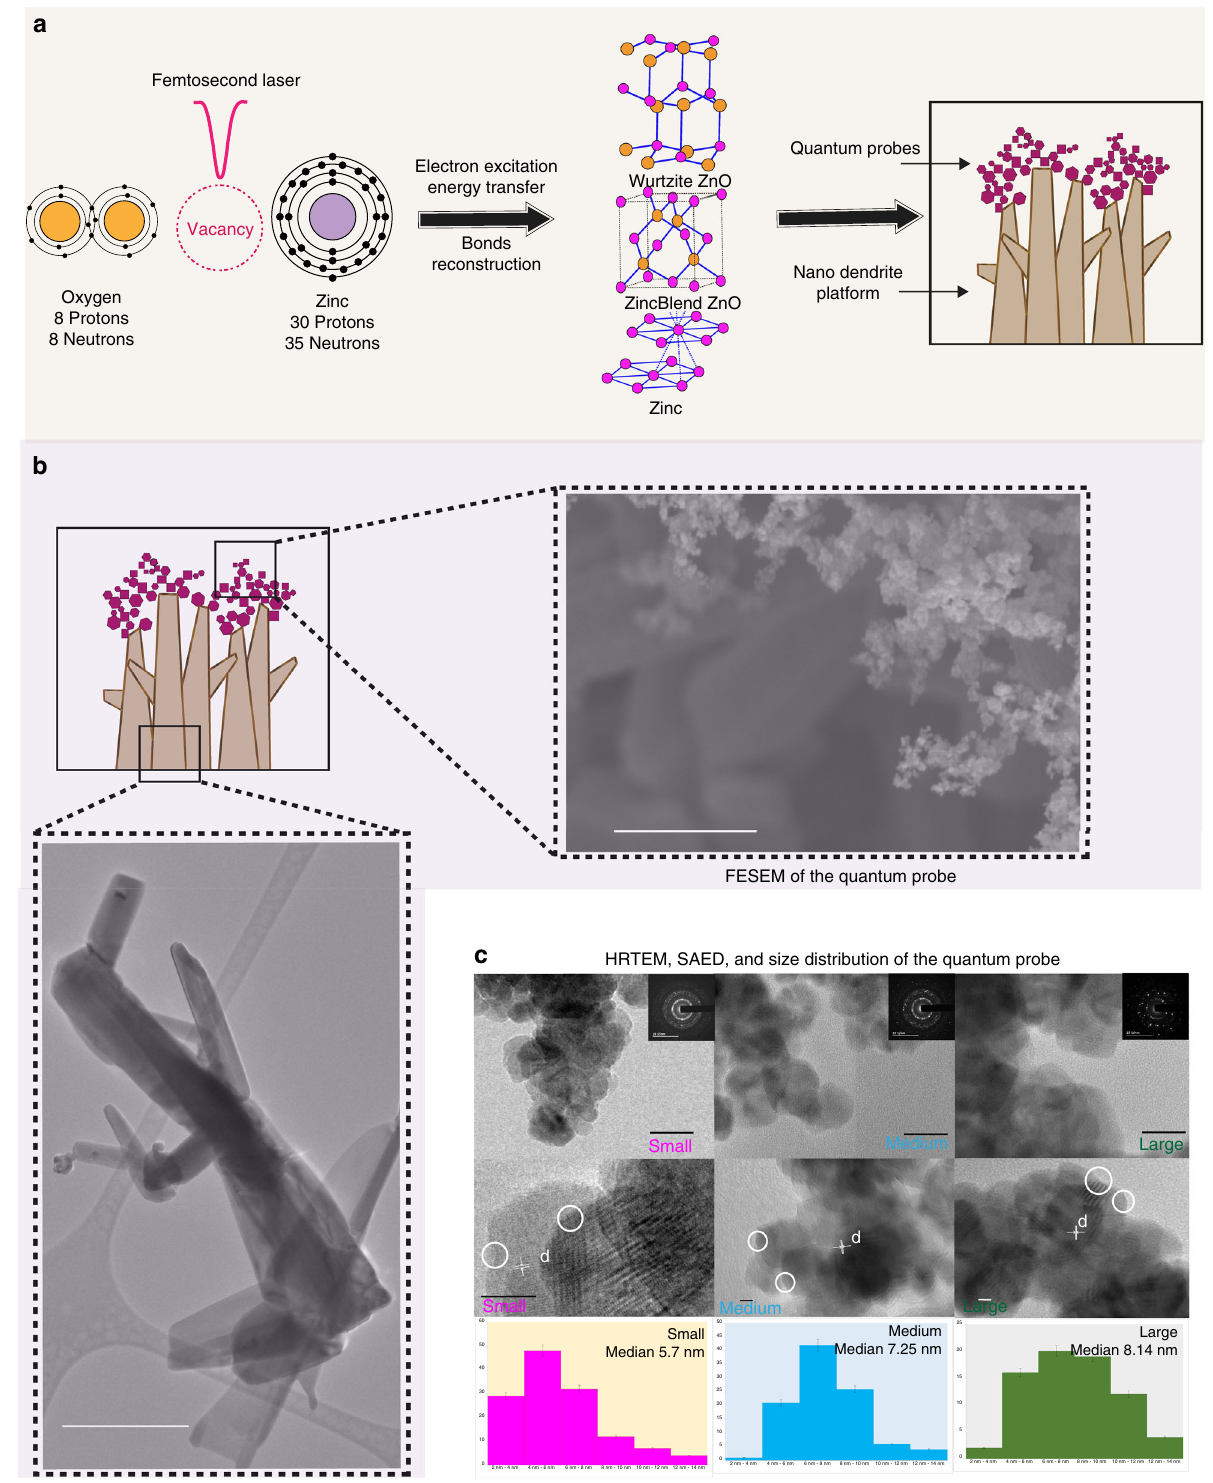
Fig. 1 Formation and characterization of the ZnO-based semiconductor quantum probe. a Formation of ZnO-based semiconductor quantum probe for SERS and nano-dendrite platform for cell adhesion by femtosecond laser interaction. b FESEM reveals 3D mesh-like assemblies of the quantum probe. Scale bar = 500 nm. c HRTEM shows the presence of hexagonal and cubical particles with stacking defaults and irregular edges, scale bar = 20 nm. Lattice spacing “ d ” indicating the presence of zinc and wurtzite/zinc blende phases of ZnO, scale bar = 5 nm. The elemental analysis revealed the presence of elemental variation of zinc and oxygen in small (Zn 62.46%, O 2 37.54%), medium (Zn 55.82%, O 2 44.18%) and large (Zn 58.7%, O 2 41.3%) probes. “ x ” Axis displays the size bins and “ y ” axis displays frequency. Particle size distribution charts include error bars in S.D. Total n = 311 samples were measured. Quantum probe was classi fi ed into small, medium, and large